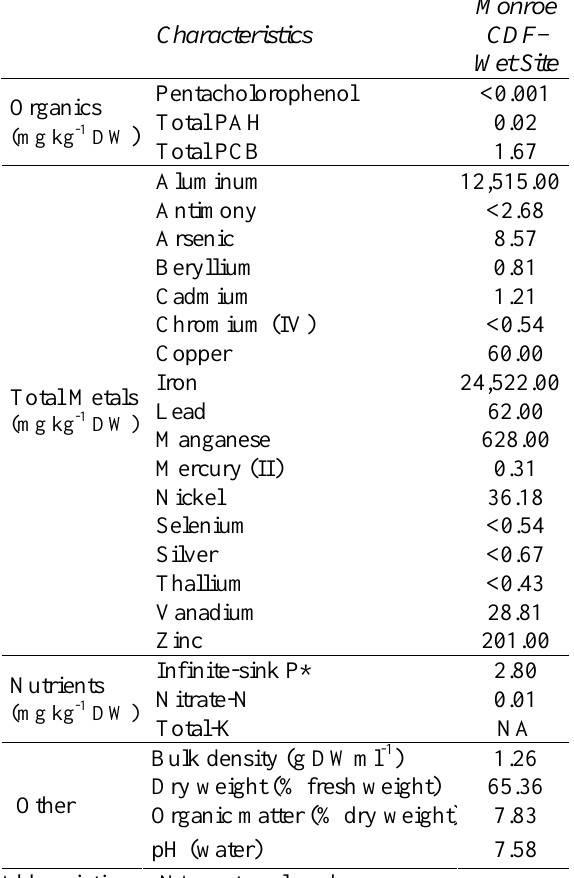
Table 3: Monroe dredged material profile